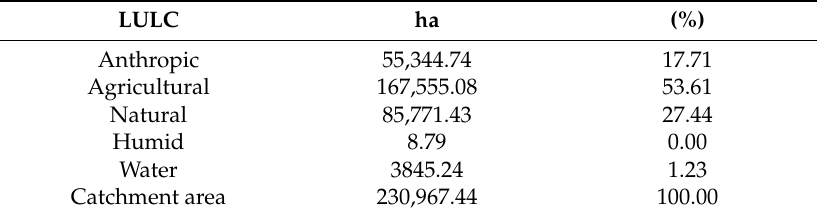
Table 1. Composition of the main land use classes (LULC) in the study